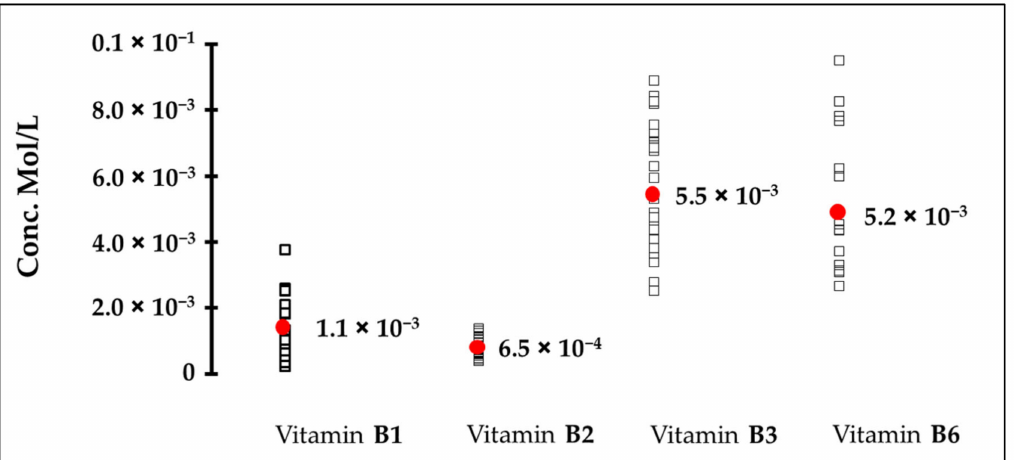
Figure 3. Human bitter taste detection threshold (mol/L) of four water-soluble